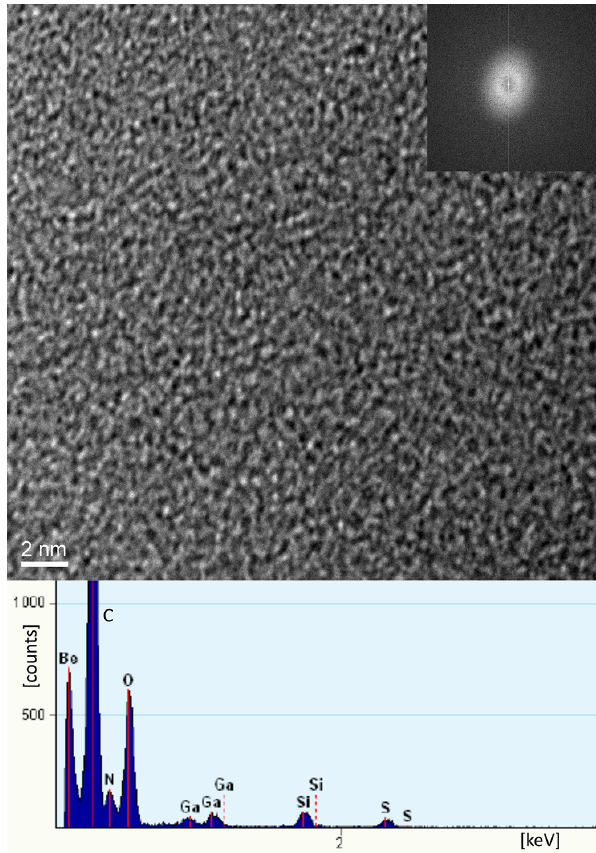
Figure 12. HRTEM image of central part of a filament showing amorphous kerite (inset is electron diffraction pattern) and EDS spectrum of a spot, confirming Si as an impurity and C–N–O and S as the kerite constituents. Ga peak is from the cutting of the FIB foil, and Be is from the Be sample